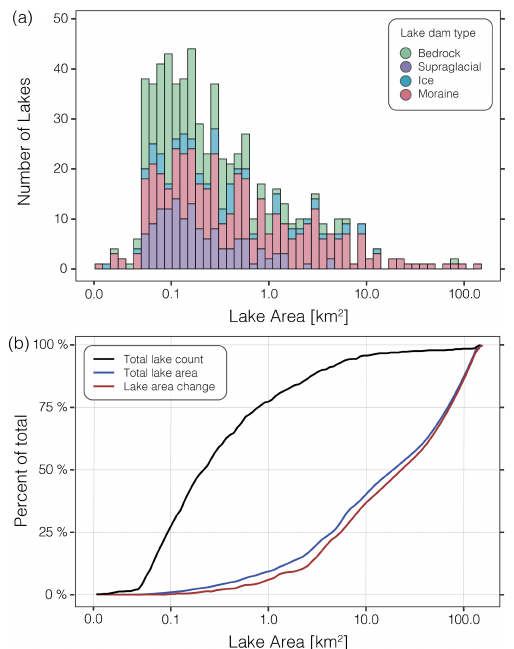
Figure 6. Distribution of lake area frequency in 2016–2019 by lake area (colored by dam type; a ) and cumulative distribution function of total lake number, total lake area, and total lake area change (1984–1988 to 2016–2019; b ). Note that the x axis is loga-